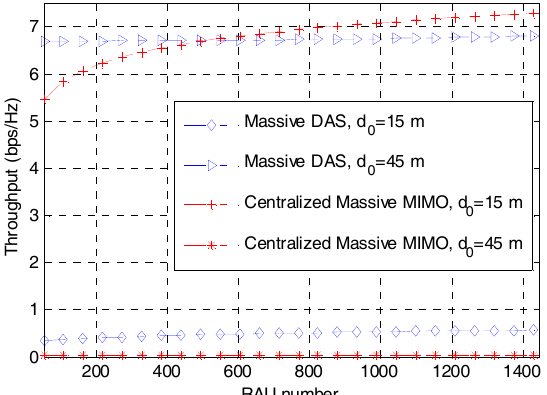
Figure 7. Throughput versus the number of remote antenna units (RAUs) for massive distributed antenna system (DAS) and centralized large-scale multiple-input multiple-output (L-MIMO).